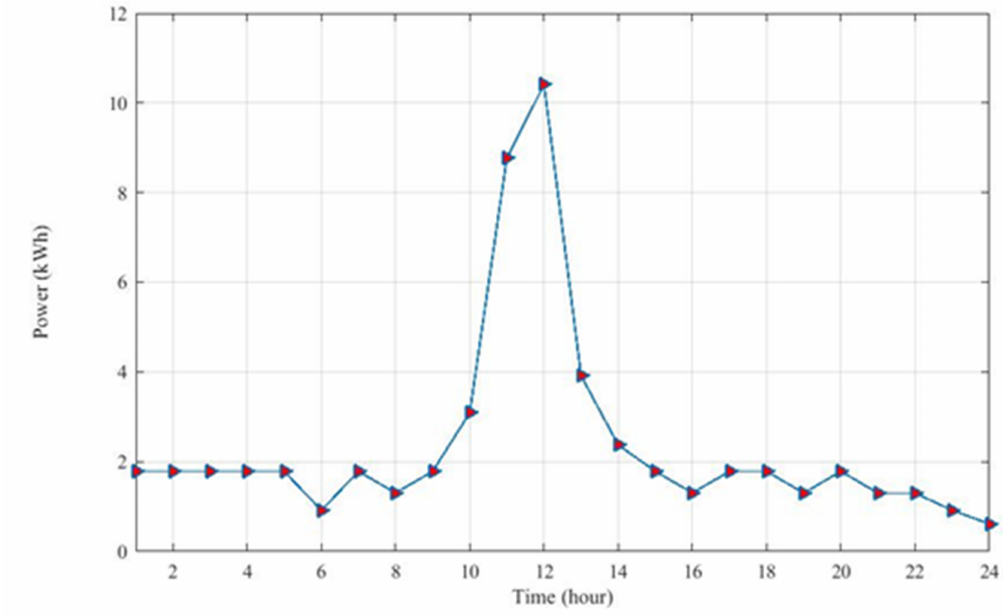
Figure 5. Forecasted power of wind turbine (WT).